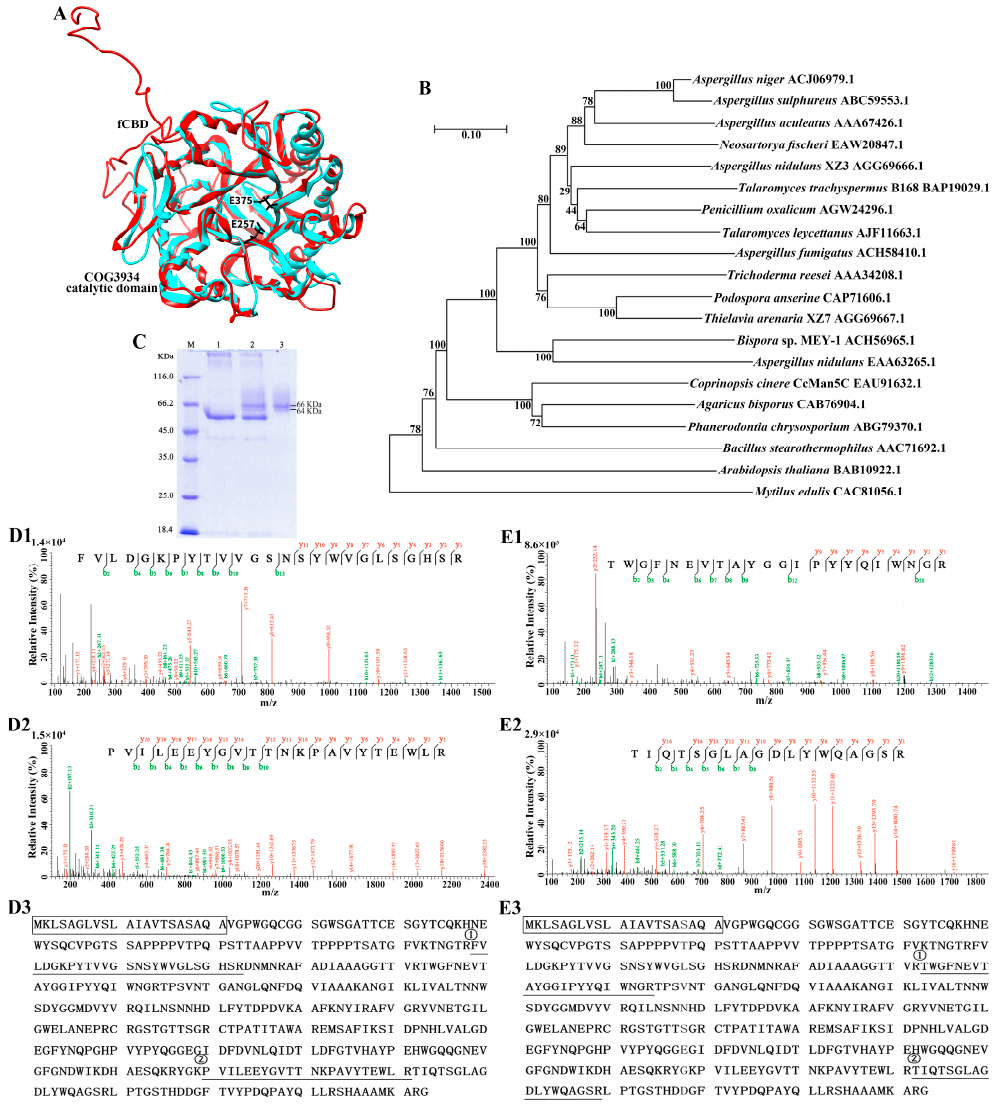
Figure 1. Sequence analysis, recombinant expression, and identification of endo- β -1,4-mannanase CcMan5C from C. cinerea. ( A ) Superimposition of the model of CcMan5C predicted by I-TASSER (red) and the closest related crystal structure of GH5 β -1,4-mannanase from Podospora anserina (PDB entry 3ZIZ, lake blue). The catalytic residues of CcMan5C are shown as black sticks. ( B ) Phylogenetic tree of β -mannanase homologs from different fungi, as well as the representative bacterium Bacillus sp., plant Arabidopsis thaliana, and animal Mytilus edulis constructed using the neighbor-joining method (1000 bootstraps) with MEGA7.0 software after ClustalW alignment. The scale bar represents 0.1 amino acid substitutions per site. Each sequence is marked with its accession No. in NCBI. ( C ) SDS-PAGE analysis. Lanes: M, standard protein markers; 1, culture medium for control stain; 2, culture medium for recombinant expression strain; 3, purified CcMan5C. ( D ) MALDI-TOF/TOF-MS spectra of the two trypsinized peptide fragments from the 66 kD band in B. Sequence 1 with a Mascot ion score of 77 and m / z 2725.35 ( D1 ) and sequence 2 with a Mascot ion score of 142 and m / z 2577.3479 ( D2 ) in the deduced amino acid sequence of CcMan5C ( 1 (cid:13) and 2 (cid:13) ) (NCBI accession: EAU91632.1) ( D3 ) are underlined, and the deduced signal peptide sequence at the N-terminus is marked by a box. ( E ) MALDI-TOF/TOF-MS spectra of the two trypsinized peptide fragments from the 64 kD band in B. Sequence 1 with a Mascot ion score of 84 and m / z 2592.2074 ( E1 ) and sequence 2 with a Mascot ion score of 103 and m / z 1922.9486 ( E2 ) were shown in the deduced amino acid sequence of